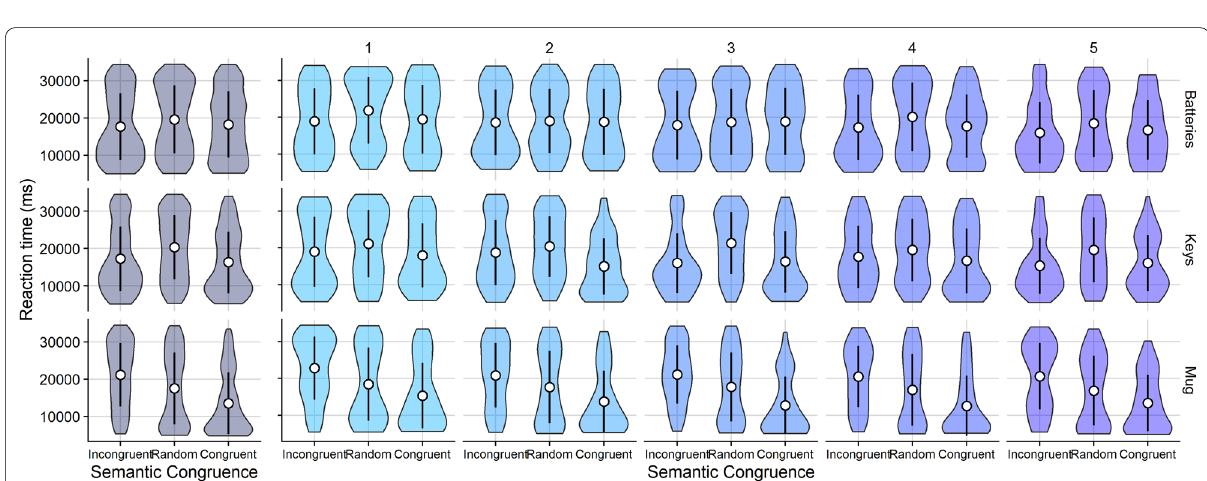
Fig. 10 Violin plots indicating reaction time for each target in each semantic congruence condition (left, each violin plot is based on between 487 and 490 observations), and additionally for each session (right, each violin plot is based on between 89 and 100 observations). White circles represent the mean and error bars represent ± 1 standard deviation